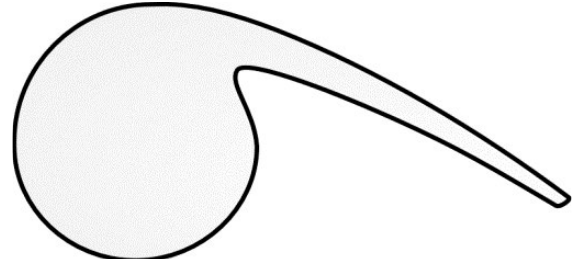
Figure 4. Illustration of a basic early